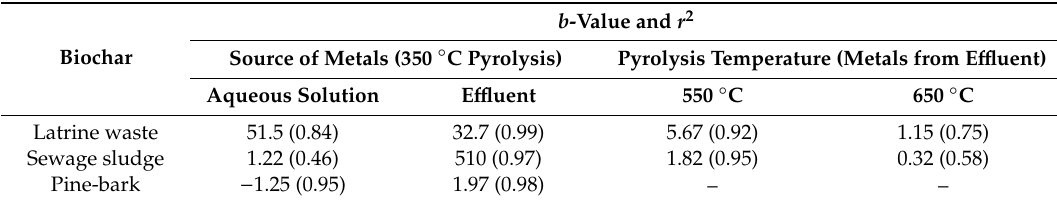
Figure 4. Maximum copper sorption on faecal and pine-bark biochar pyrolysed at 350 °C ( a ) and on faecal biochar at increasing pyrolysis temperatures ( b ). Table 2. The b (L kg − 1 ) and r 2 values of linearized Langmuir models of copper on biochars from latrine waste, sewage sludge and pine bark.